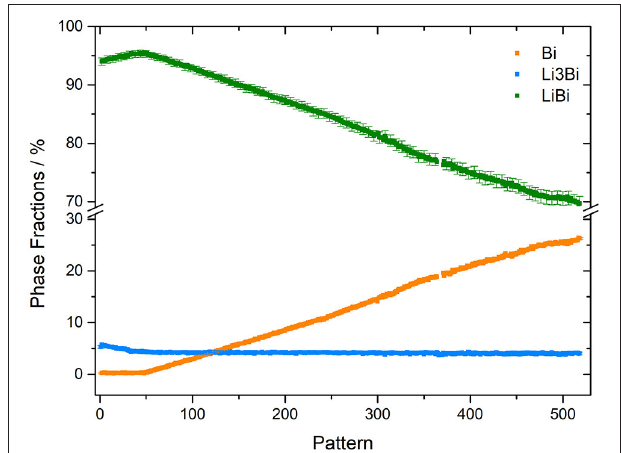
FIGURE 4 | Phase fractions as a function of pattern number as determined by Rietveld